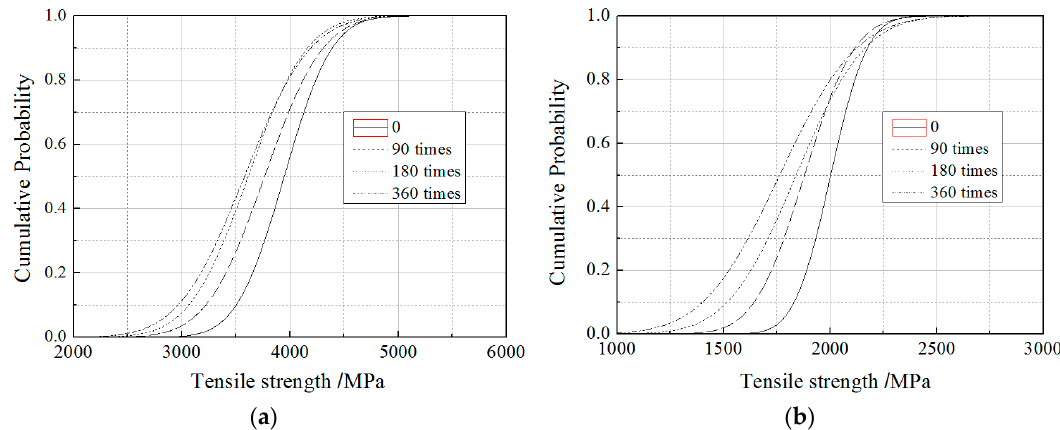
Figure 5. Cumulative distribution of FRP tensile strength: ( a ) CFRP; and ( b ) GFRP.